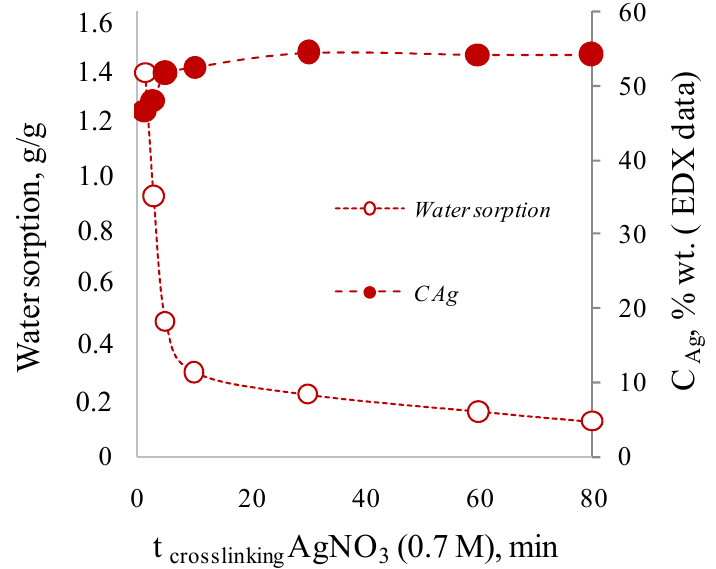
Figure 2. Silver distribution along the thickness of cross-linked alginate. Interestingly, the use of a highly concentrated solution of 0.7 M (10.6% wt.) silver nitrate leads to different results. Thus, the concentration of silver in the membranes cross-linked by highly concentrated solution for 1.5 to 80 min was 47.8–54.5% wt.; that is significantly higher than the maximum theoretical possible content of silver equal to 38%. At the same time, an increase of the cross-linking time up to 30 min leads to an increase of silver concentration, to visual “densification” of the film and decrease of water sorption values for dried samples (Figure 3). It is worth noting that cross-linking less than 1.5 min leads to the formation of films subsequently strongly swelling in water, losing their shape and mechanical strength.